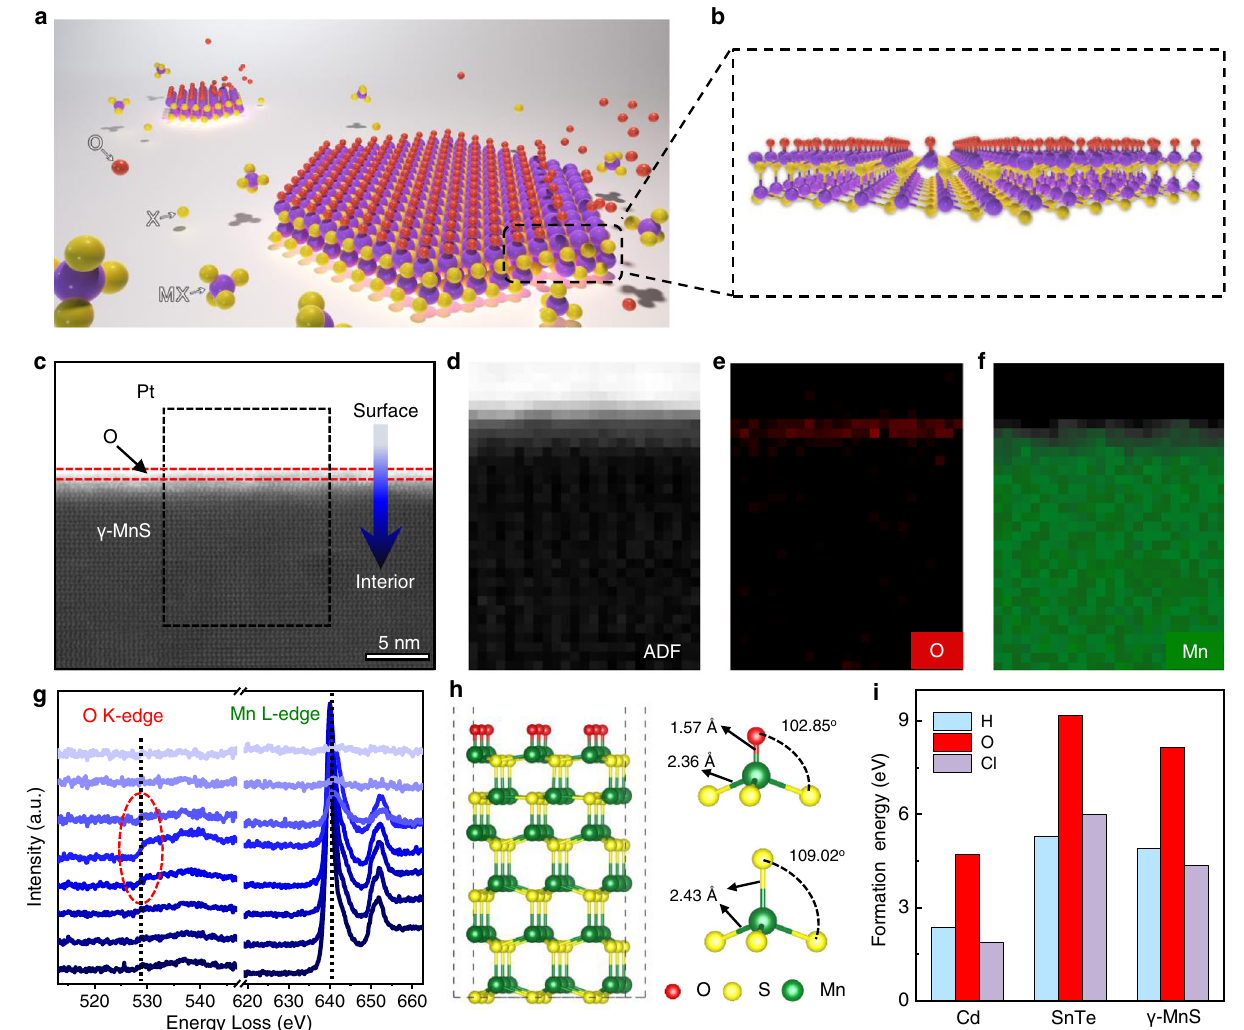
g EELSspectracorrespondingtotheOK-edge(leftverticalposition)andMnL-edge (right vertical position) from the surface to the interior region. The red dotted frameisthesurfacepositionsofthenanosheets. h Schematicviewofthedistortion O-terminated MnS (001) surface. i Formation energy of adsorbing H, O and Cl on the surface of Cd, SnTe and